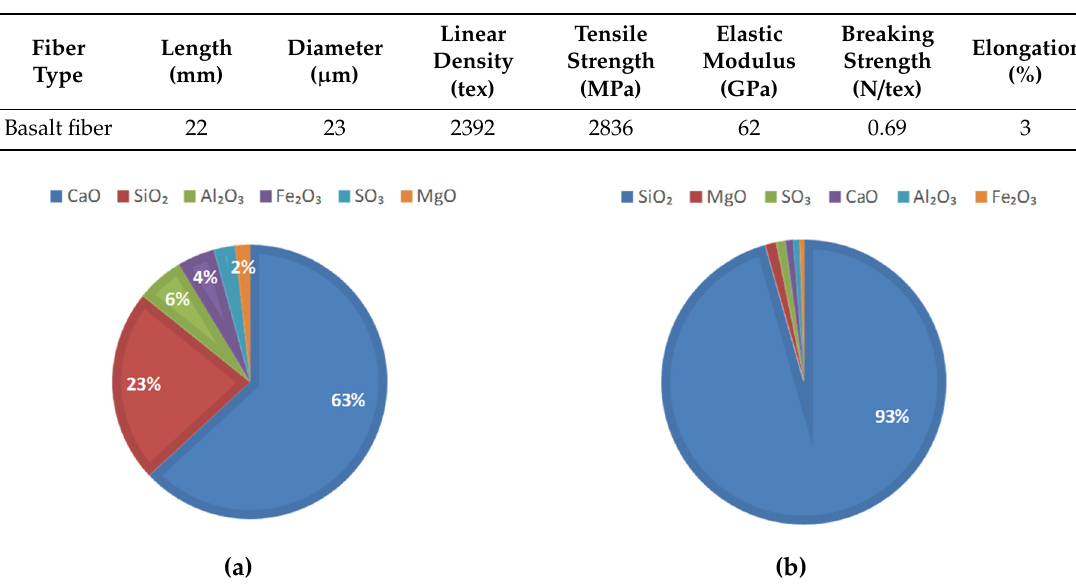
Figure 3. Chemical composition of cementing materials: ( a ) cement; ( b ) silica fume.